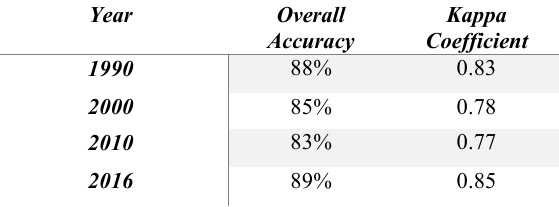
Table 3 Accuracy assessment of classified images